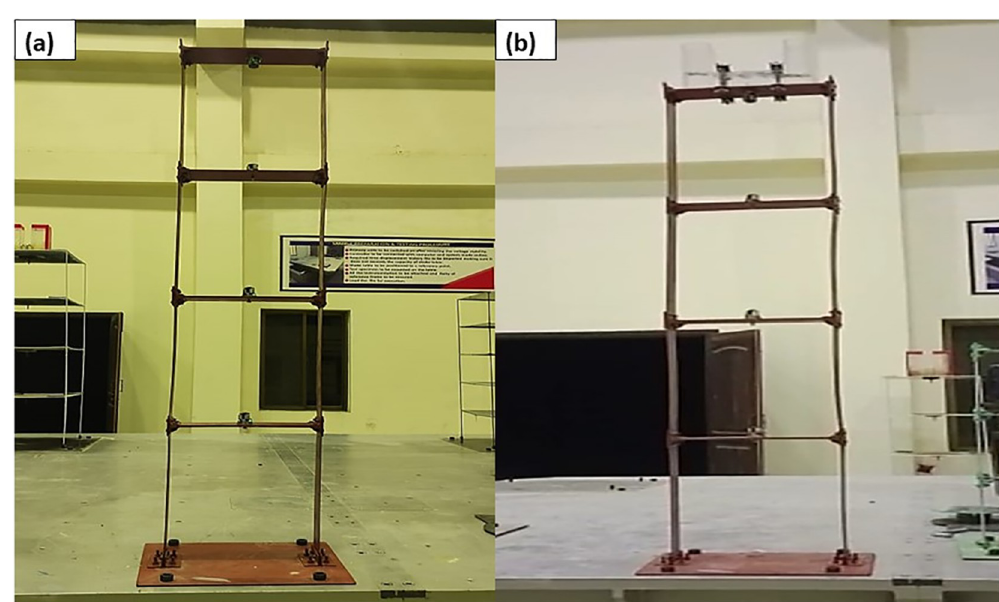
Fig 2. Frame structures (a) Uncontrolled MDOF structure, (b) MDOF structure equipped with TLCD.